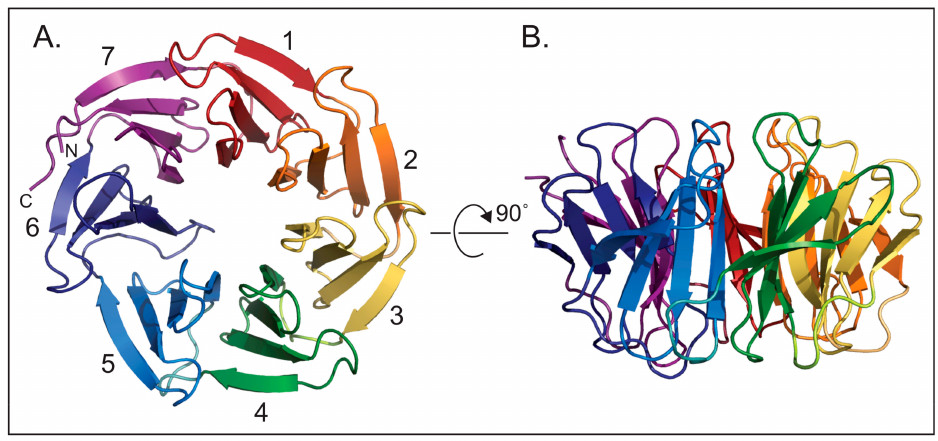
Figure 1. WDR5 is a seven bladed β -propeller protein. ( A ) This orientation of WDR5 displays the seven β -propeller blades of WDR5 each in a different color. The blades are numbered one to seven from the N-terminus starting with the first full blade. ( B ) Side view of the orientation of the structure in A. (PDB ID